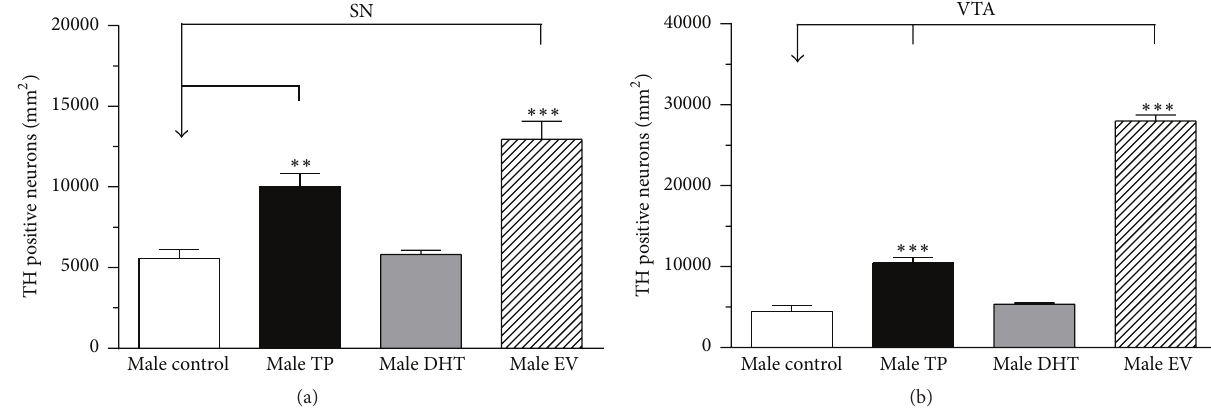
Figure 3: Quantitative analysis of tyrosine hydroxylase- (TH-) positive neurons in SN (a) and VTA (b) of adult male rats (PND 60) Data are expressed as the mean ± SEM (control 𝑛 = 3 , TP = 4, DHT = 3, and EV = 5) ( ∗∗∗ 𝑃 < 0.0001 , ∗∗ 𝑃 < 0.01 , and ∗ 𝑃 < 0.05 ; one-way ANOVA followed by the Newman-Keuls multiple comparison test).